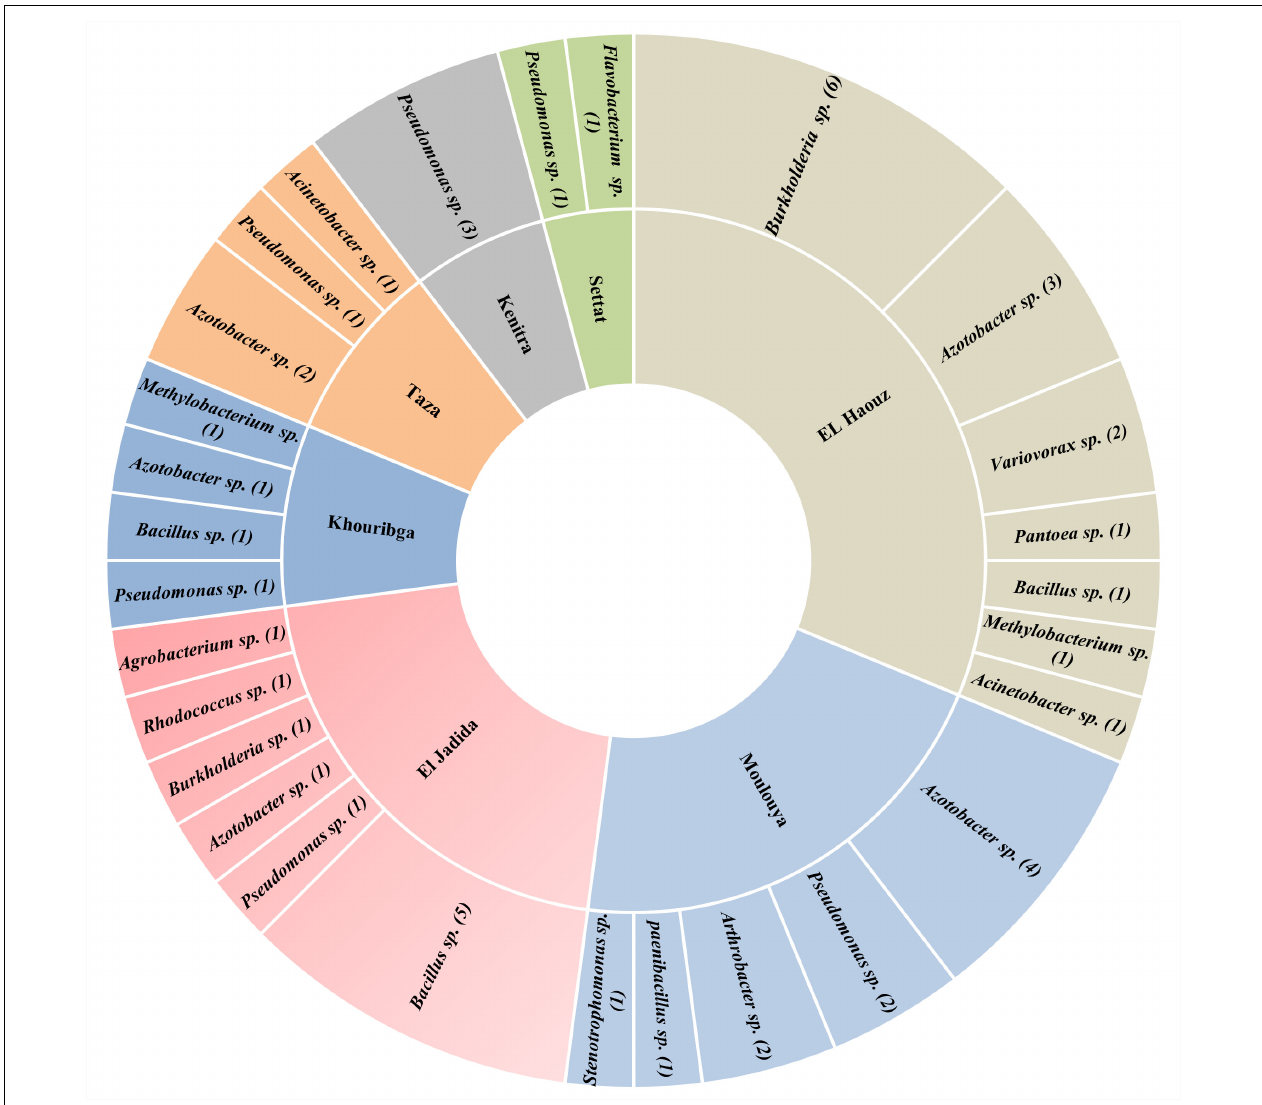
FIGURE 2 | Number and distribution of major free N 2 -Fixing species identified in seven agricultural locations representative of Moroccan agricultural soils using 16S rDNA